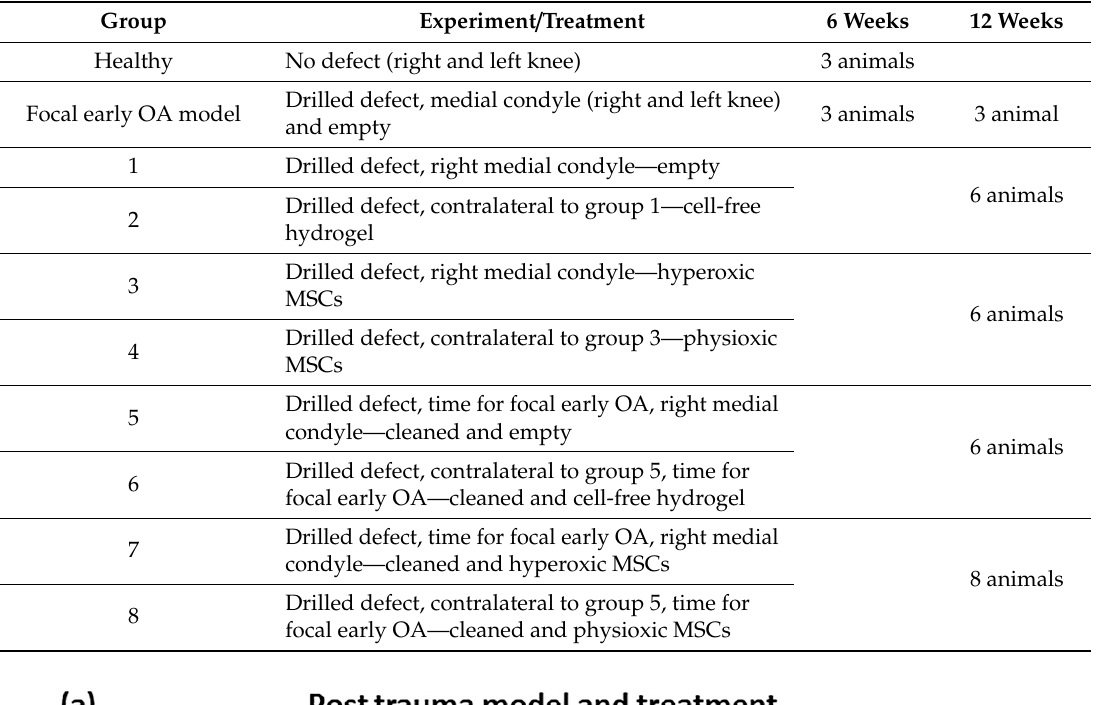
Table 1. Summary of the groups and respective treatments for the animals used in the in vivo studies. See Figures 1 and 2 for a schematic representation of the table.